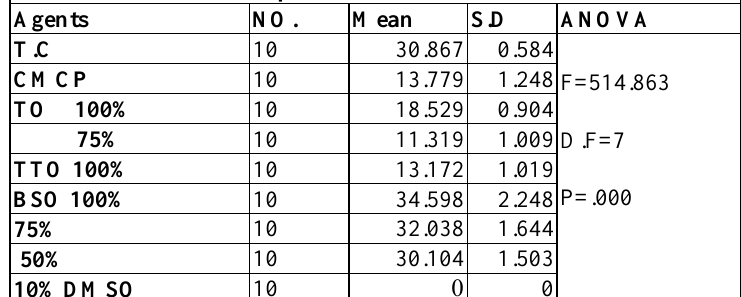
Table 4: LSD among T.C, CMCP and each concentration of tested oils(vaporization ) Control Agents Mean Difference